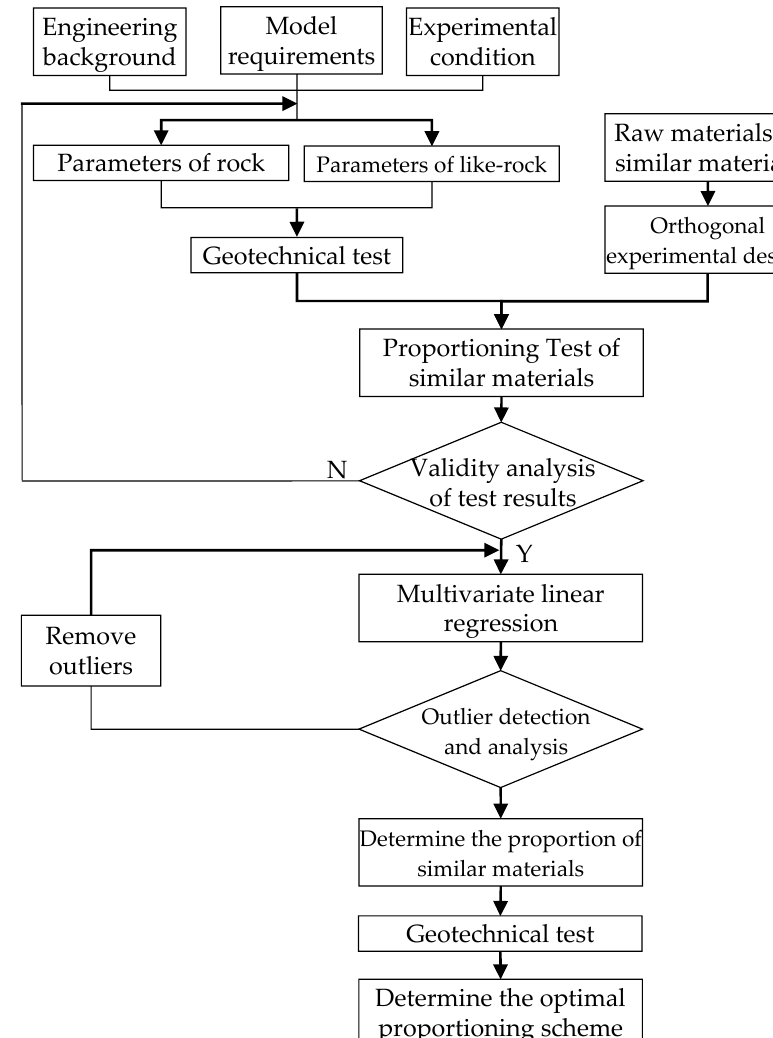
Figure 1. Flow chart of determining the similar material proportion.